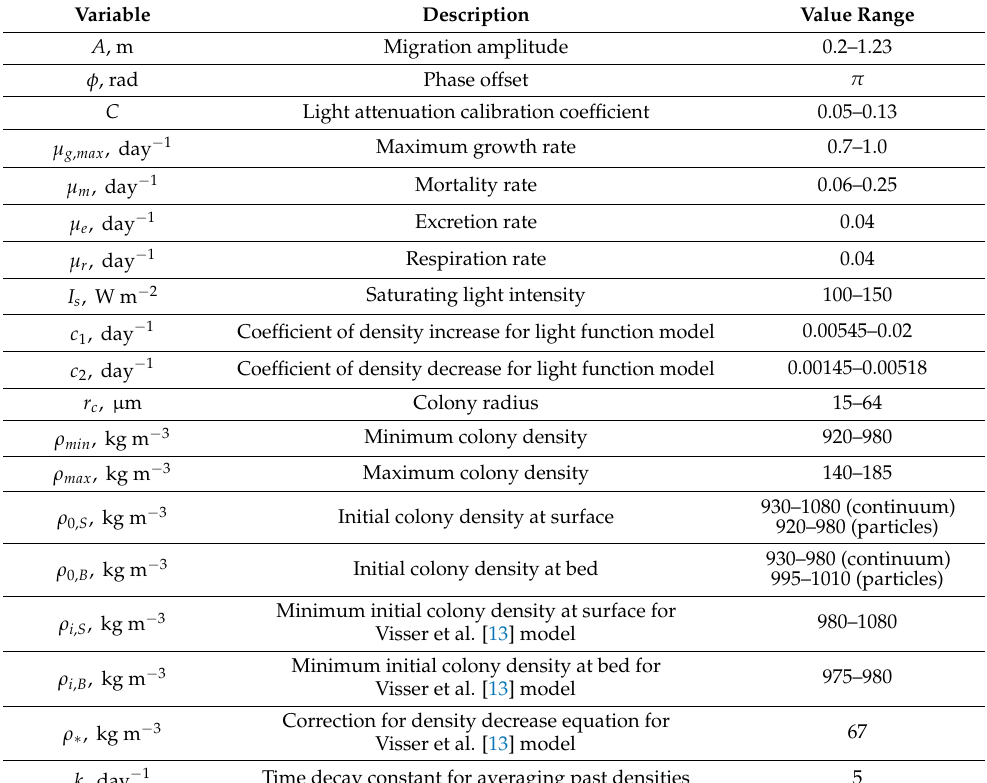
Table 3. Ranges of values used in model applications to field study